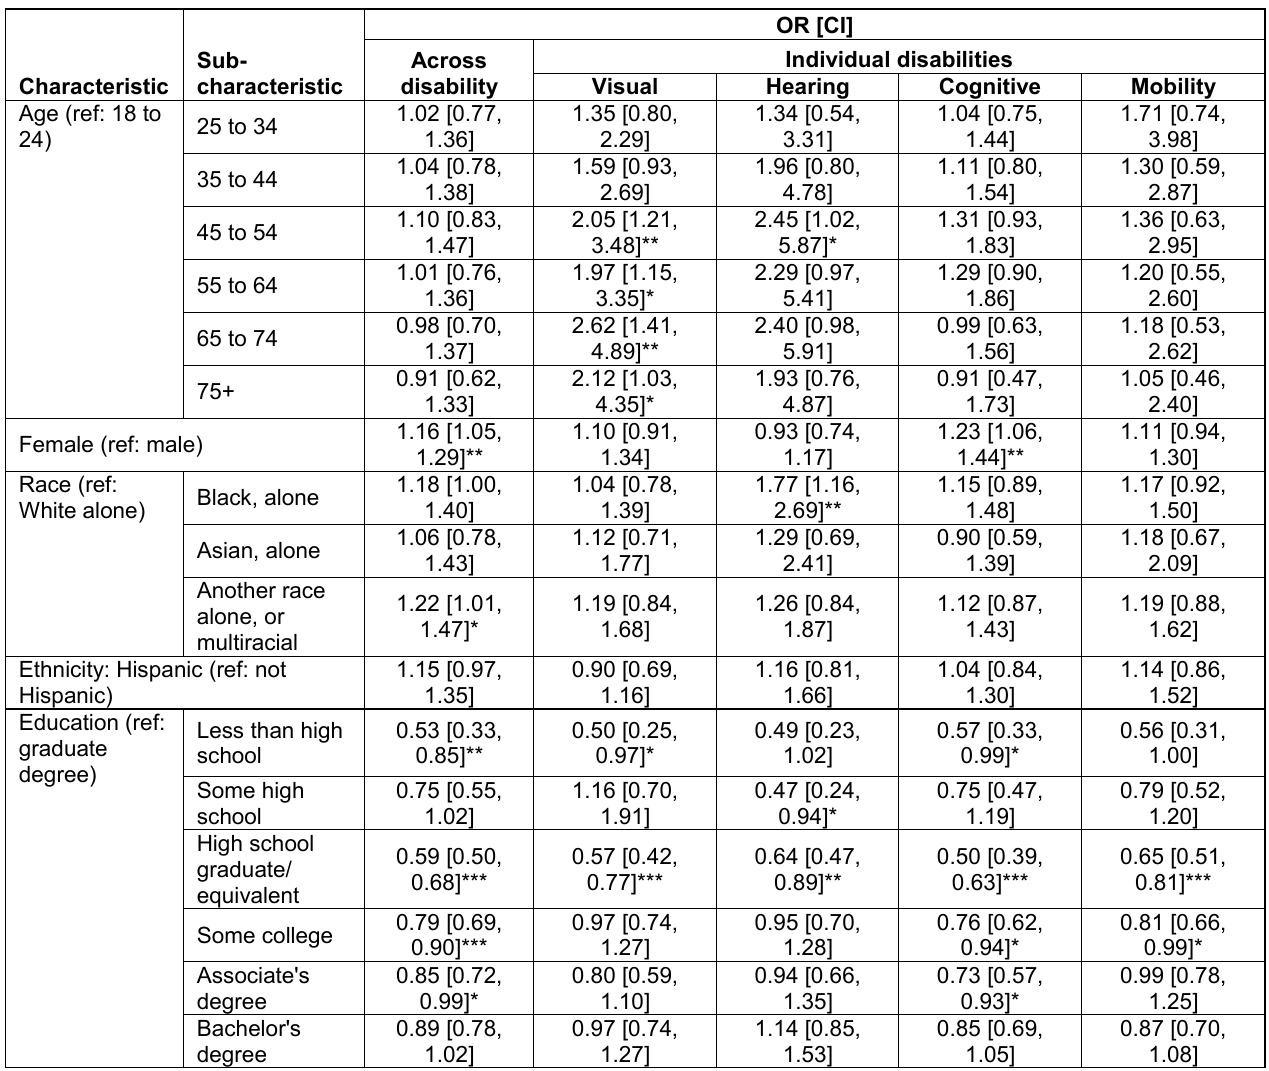
Correlates of Telehealth Use by PWDS during the Pandemic